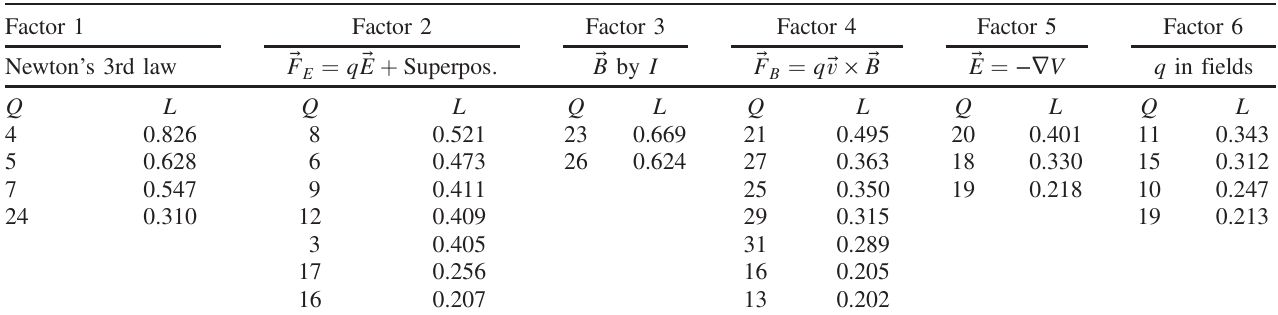
TABLE II. CSEM 6 factor EFA model. The following items had to be dropped due to their communality values falling below the 0.1 cutoff value: 1, 2, 14, 22, 28, 30, and 32. All loading values above 0.2 were retained in the presented model. Within this table “ Q ” indicated the questions number and “ L ” the associated loading